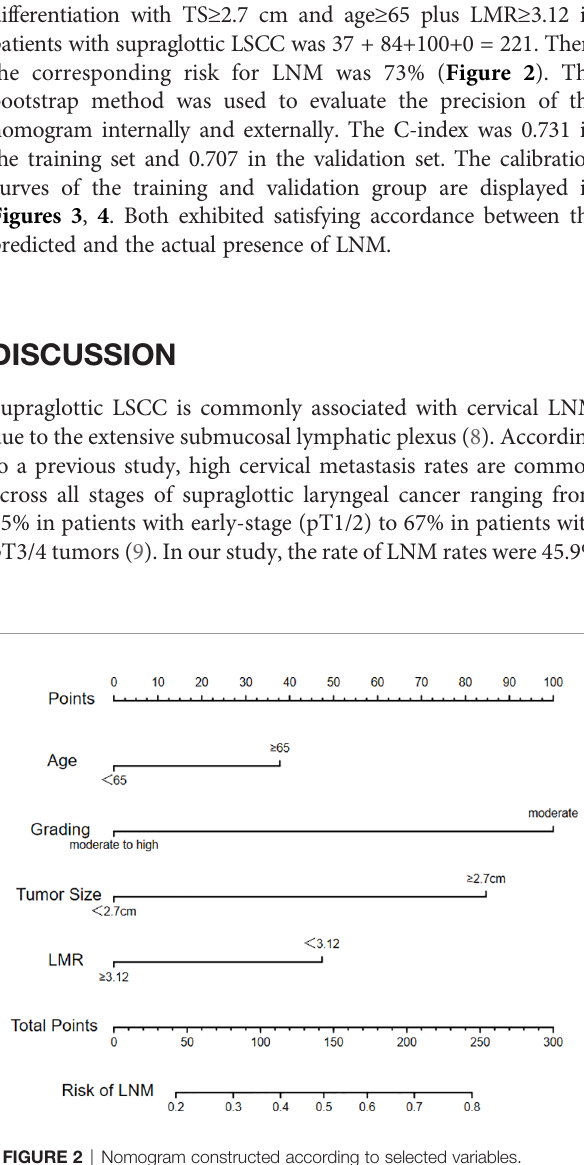
FIGURE 2 | Nomogram constructed according to selected variables.